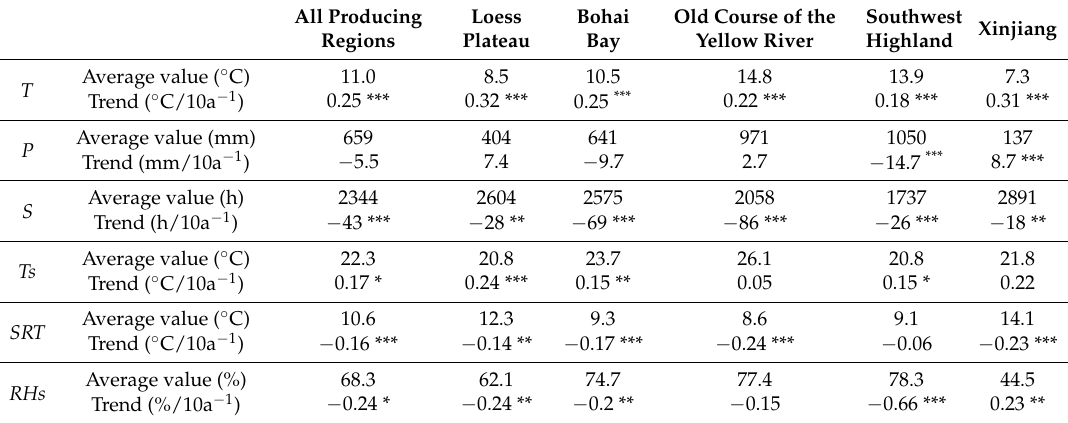
Table 2. Average values and change trend ratios of the major climate factors affecting apple quality in China.